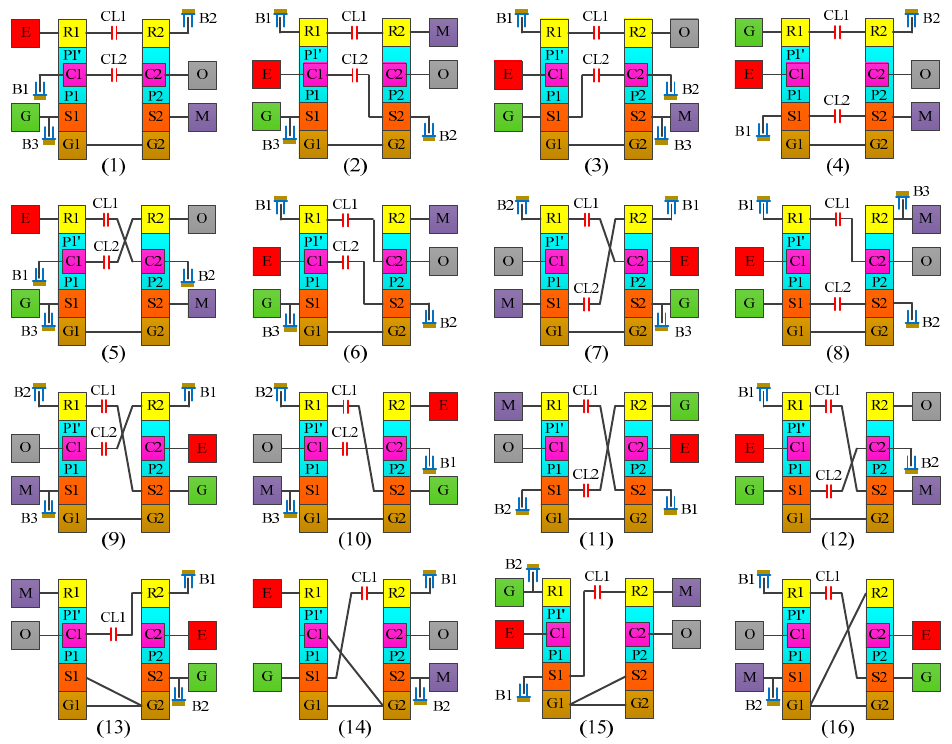
Figure 9. Partial atlas of series-parallel hybrid transmissions. E: engine; M: motor; G: generator;